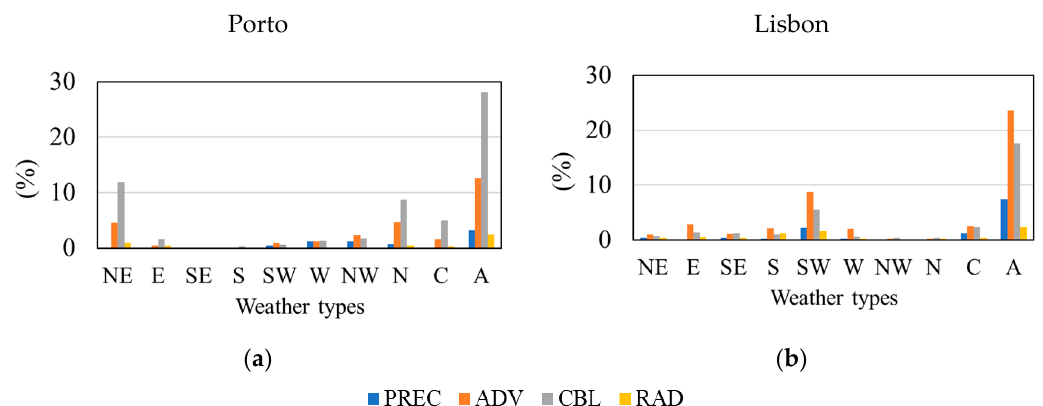
Figure 8. Relative frequency of the fog event types associated to weather types at the airports of Porto ( a ) and Lisbon ( b ).